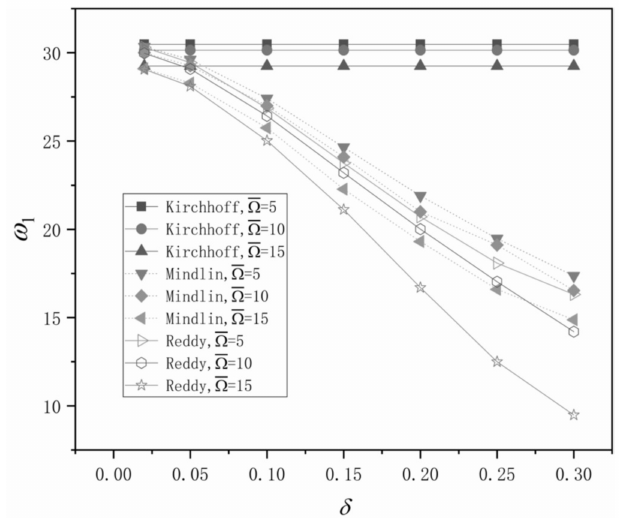
Figure 11. The influence of the thickness-to-radius ratio and rotational velocity on the first-order natural frequencies under different plate theories ( k = 5, s = 0.1, τ = 0.05, ∆ T = 0 K ).